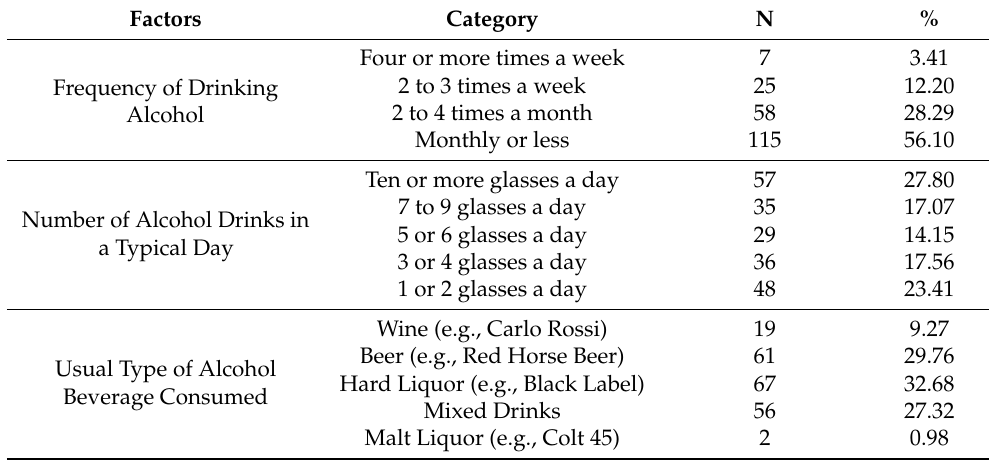
Table 4. Customer Preference & Alcohol Consumption.